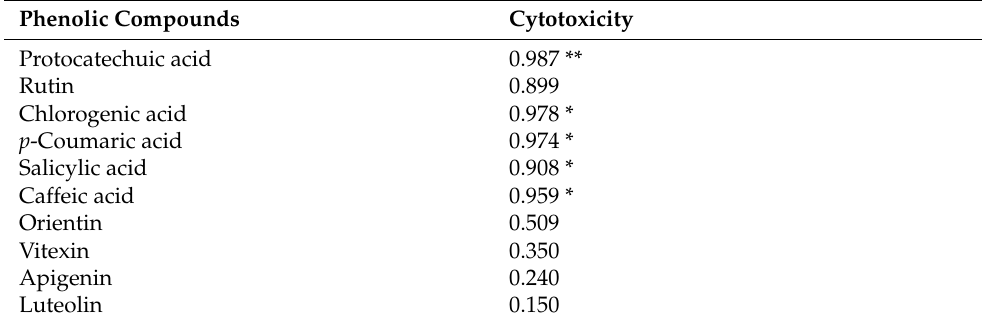
Table 5. Pearson correlation coefficients between the phenolic compounds and cytotoxicity of the A.